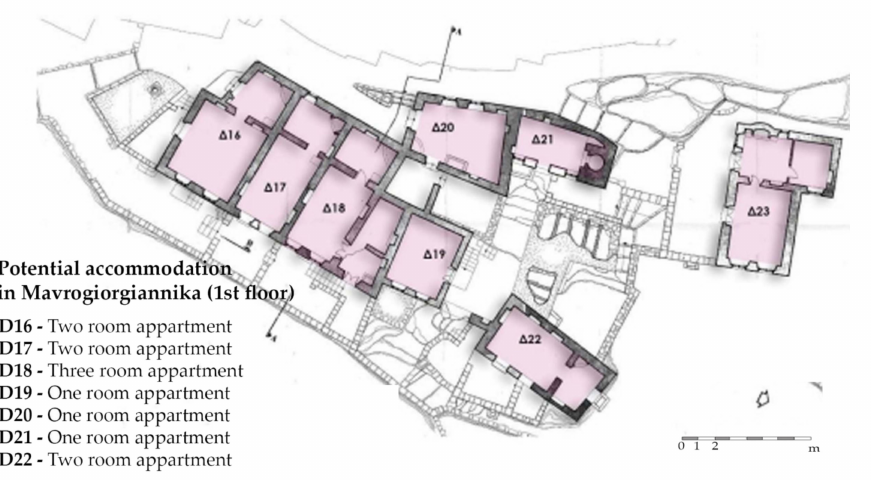
Figure 29. Potential accommodation in Mavrogiorgiannika (1st floor)—modified after C.Sougiannis